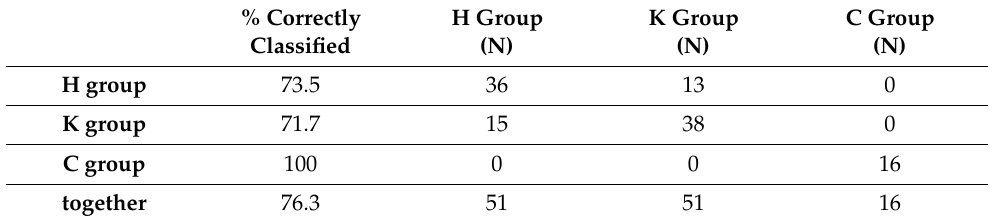
Table 4. Results of the discriminant analysis—percentage and number of correctly classified participants.